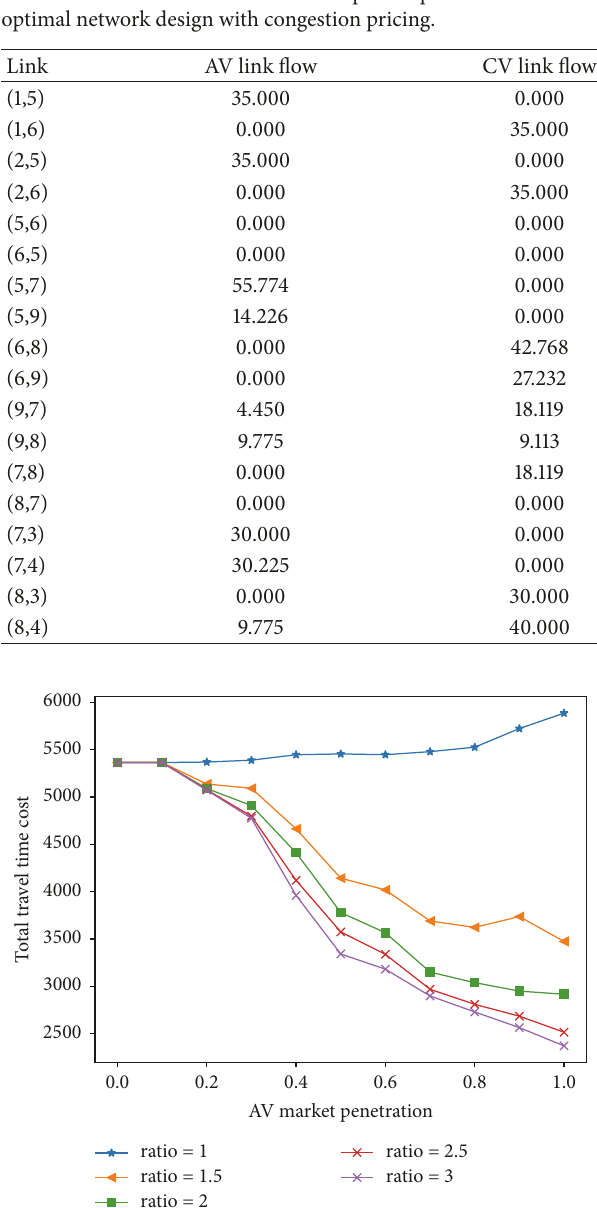
Figure 4: Variances of total travel-time cost with AV market penetrations.